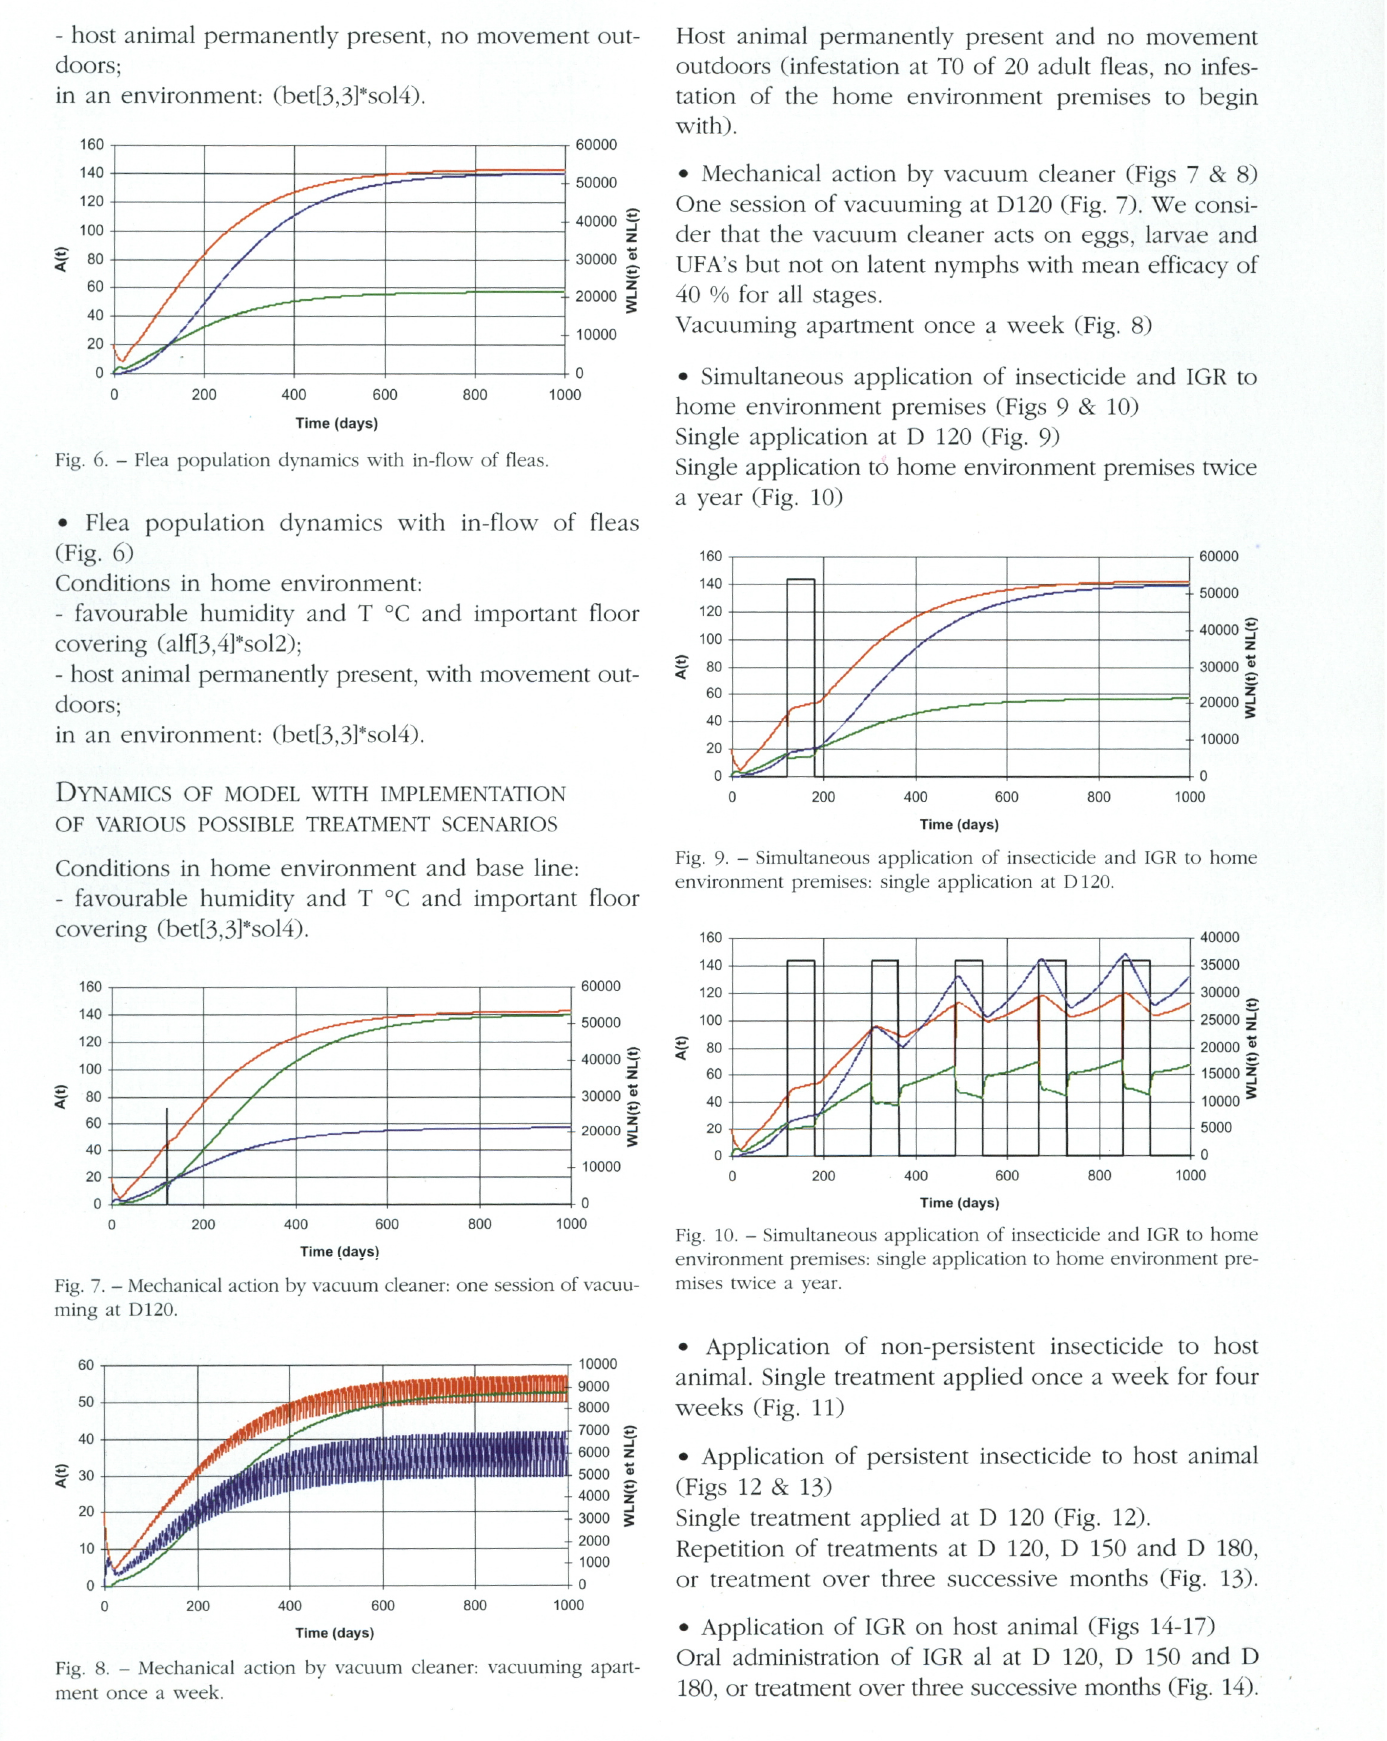
Fig. 8. - Mechanical action by vacuum cleaner: vacuuming apart­ ment once a